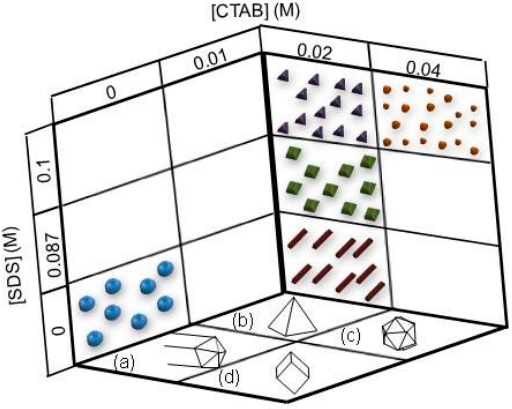
Figure 2. Schematic of growth of homogenous shapes according to surfactant variation: ( a ) Growth of a rod structure from the decahedral precursor; ( b ) tetrahedral precursor geometry; ( c ) polyhedral precursor geometry; and ( d ) cuboctahedral precursor geometry growing from the (100) and (111) planes. CTAB: cetyltrimethylammonium bromide; SDS: sodium dodecyl sulphate.